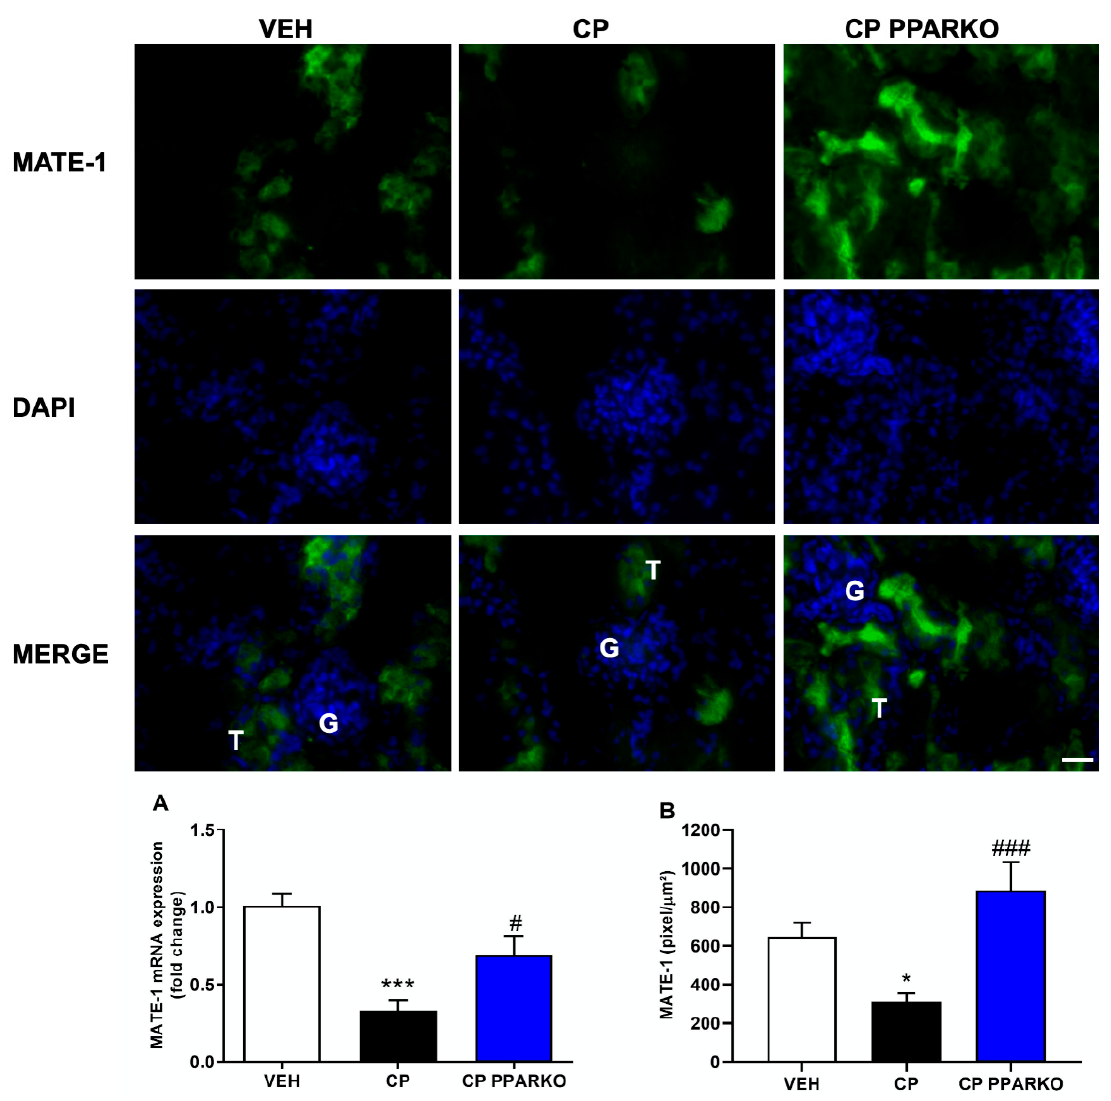
Figure 3. PPAR- α knockout mice mitigate the decreased mRNA and protein expression by immunofluorescence of MATE-1. Ninety-six hours after cisplatin treatment (CP) downregulates ( A ) mRNA and ( B ) protein levels of MATE-1. PPAR- α knockout mice (CP PPARKO) prevented this downregulation. G to indicate glomeruli and a T to indicate tubules. n = 5 per group. One-way ANOVA followed by post hoc Tukey´s test. Scale bar = 100 µm. * p < 0.05, *** p < 0.001 compared to the VEH group. # p < 0.05, ### p < 0.001 compared to the CP group.